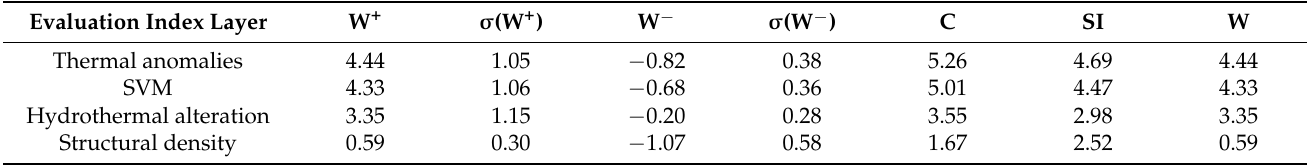
Table 7. Statistical parameters for the binarization of evidence